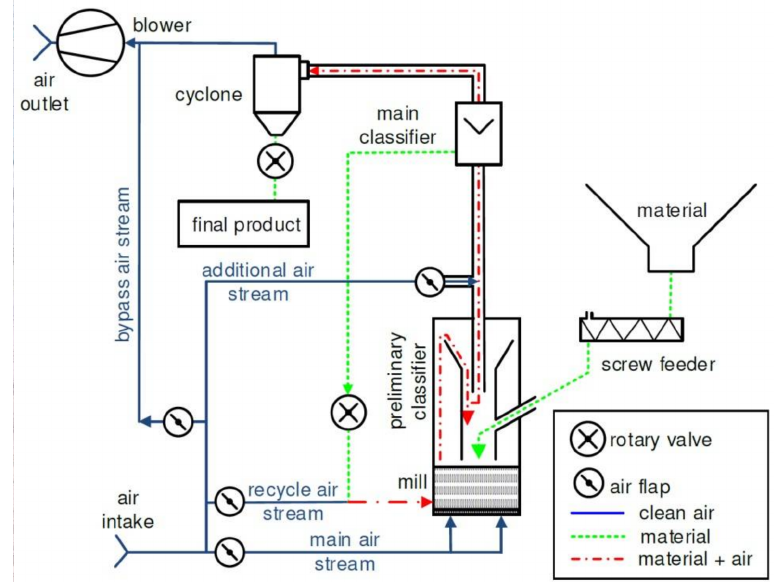
Figure 3. General scheme of the milling system with electromagnetic